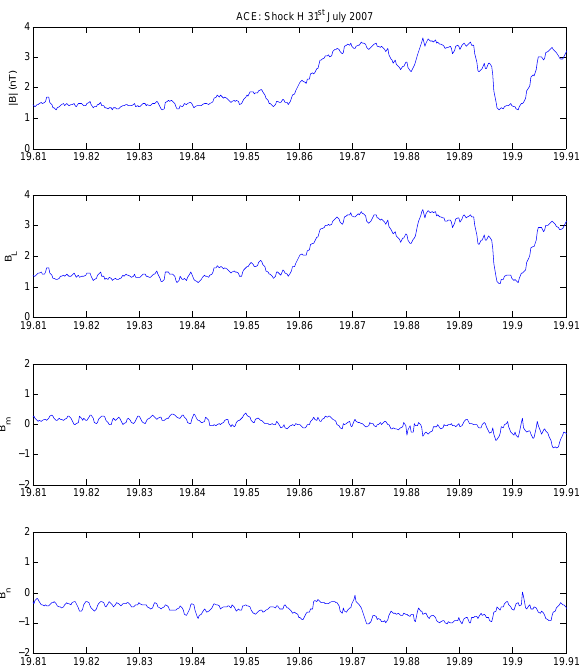
Fig. 11. An example of a nonlinear structure that did not fulfil cri- teria for a shock crossing. This structure was observed by ACE at 20.11UTC on 31 July 2007. In this case, the main magnetic field component ( B L ) crosses the zero axis in the shock coordinated frame. See caption of Fig. 7 for | B | , B L , B m and B n .